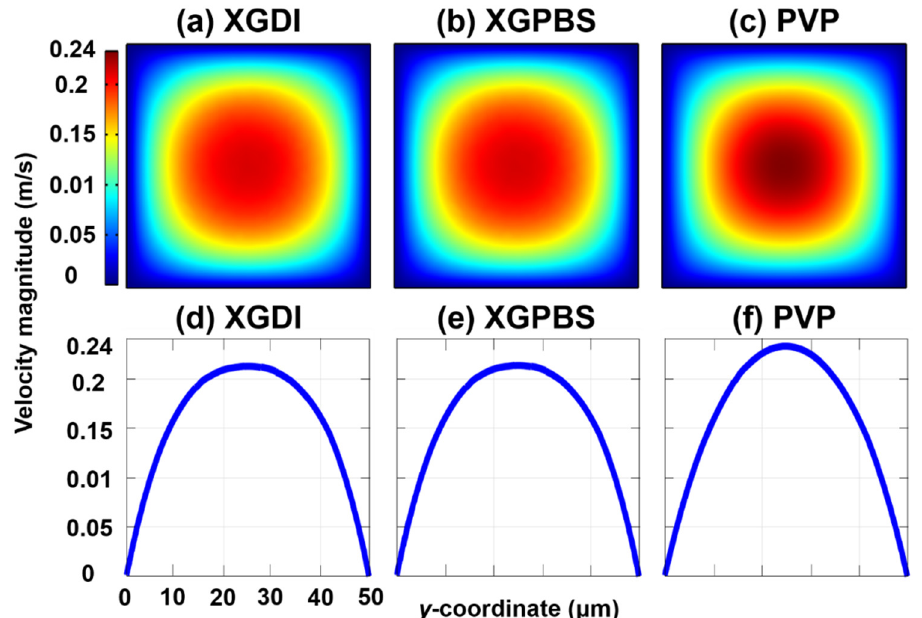
Figure 3. Numerical simulations for viscoelastic fluids i.e., shear-thinning xanthan gum (XG) solutions (XGDI and XGPBS) and viscoelastic fluid with constant shear viscosity (PVP) using a commercial finite element method software (COMSOL Multiphysics ® ) at Q = 1 mL · h − 1 , where the Carreau and Newtonian constitutive equations were employed for the XG solutions and PVP solution, respectively. ( a – c ) The upper contour diagrams denote the velocity magnitude distributions in the cross-section of XGDI, XGPBS, and PVP, respectively. ( d – f ) The lower graphs denote the stream-wise velocity magnitude distributions of XGDI, XGPBS, and PVP at the channel mid-plane, respectively.